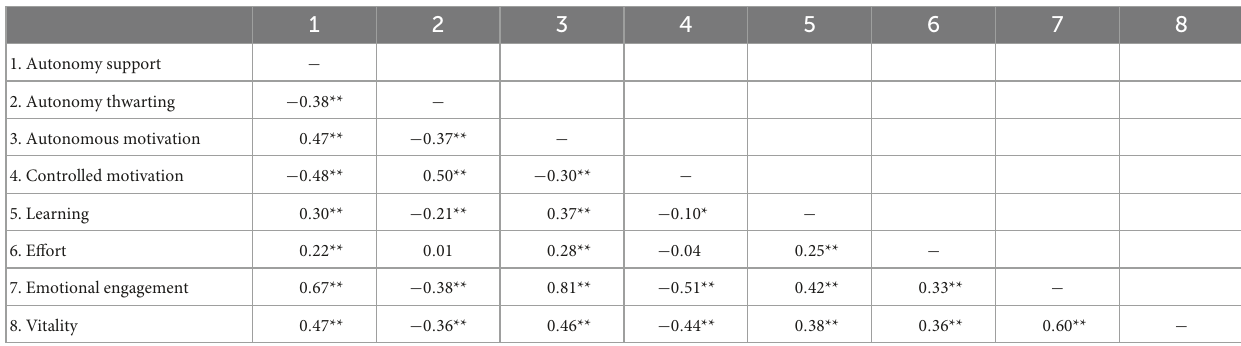
TABLE 2 Correlations of the main